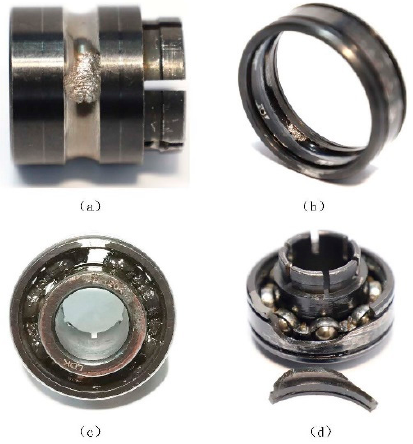
Figure 8. Sampling settings for vibration signals.